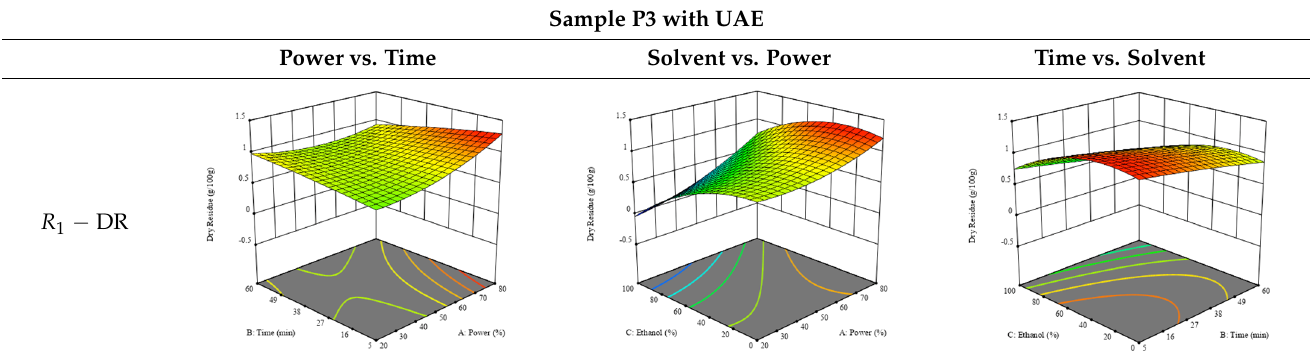
Table 10. 3D response charts of the UAE of ‘Leuka melitis’ peel (P3) at the optimal values. Sample P3 with UAE Power vs. Time Solvent vs. Power Time vs. Solvent